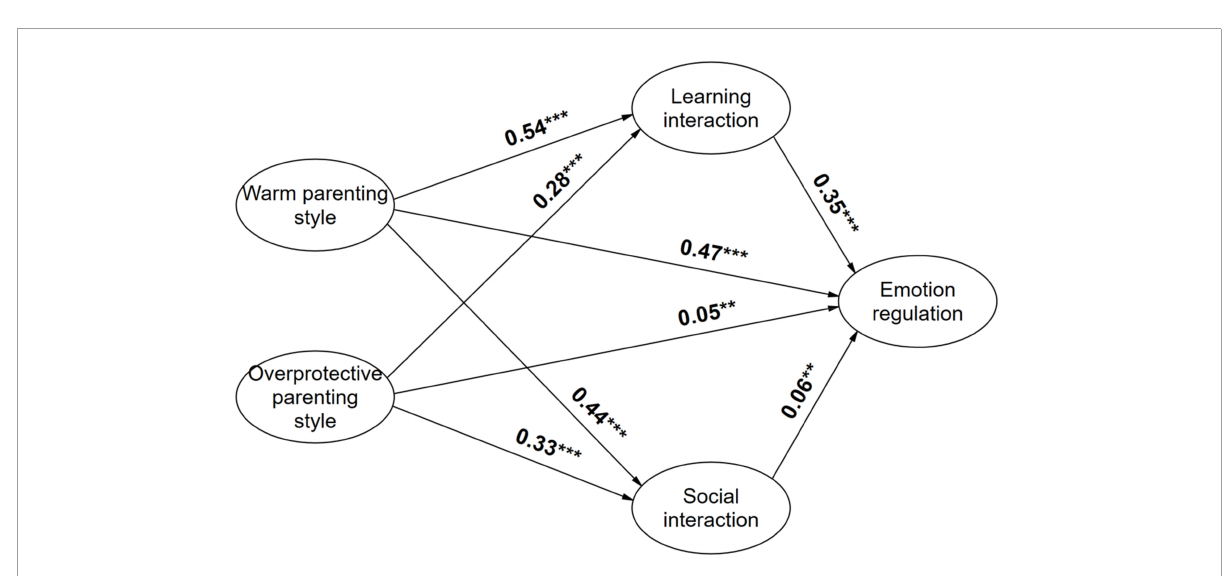
FIGURE3 Map of impact path coefficients for female sample. * p < 0.05; ** p < 0.01; *** p <